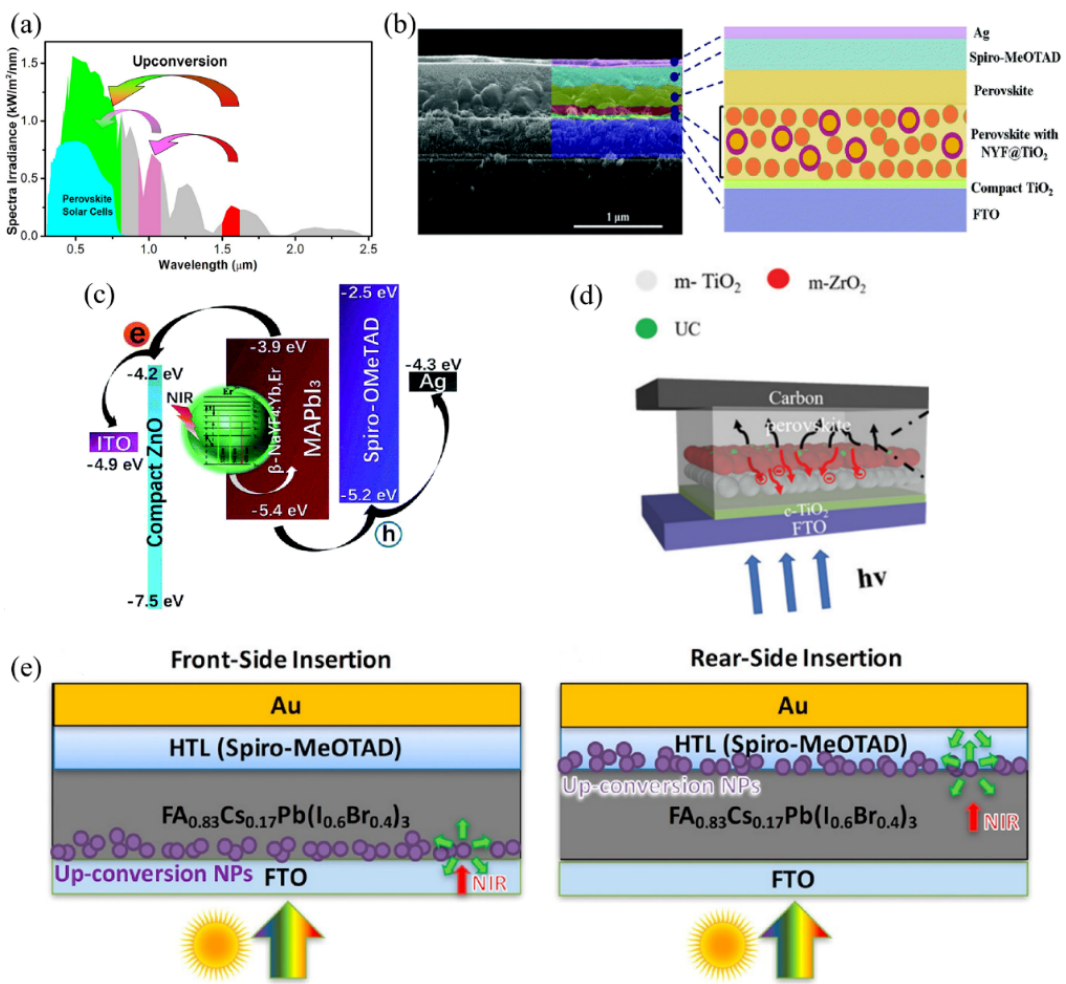
Figure 2. ( a ) The absorption regions of perovskite solar cells in the AM 1.5G solar spectrum via the up-conversion processes (Reprinted/adapted with permission from Ref. [22]. Copyright 2016 American Chemical Society); ( b ) Cross-sectional SEM image and schematic diagram of FTO/compact-TiO 2 /NaYF 4 :Yb/Er-CH 3 NH 3 PbI 3 /Spiro-MeOTAD/Ag (Reprinted/adapted with permission from Ref. [24]. Copyright 2016 RSC Pub); ( c ) Energy transfer illustration in the device of ITO/ZnO/ β -NaYF 4 :Yb/Er-CH 3 NH 3 PbI 3 /Spiro-OMeTAD/Ag (Reprinted/adapted with permission from Ref. [25]. Copyright 2017 RSC Pub); ( d ) Diagrams for device structure of FTO/cp-TiO 2 /mp-TiO 2 /mp-ZrO 2 -NaYF 4 :Ho 3+ /FA 0.4 MA 0.6 PbI 3 /C and mechanism of NIR light harvesting and up-conversion processes (Reprinted/adapted with permission from Ref. [24]. Copyright 2018 RSC Pub); ( e ) I Sketch maps for device structure of FTO/FA 0.83 Cs 0.17 Pb(I 0.6 Br 0.4 ) 3 /Spiro-MeOTAD/Au with inserting KY 7 F 22 :Yb 3+ , Er 3+ UCNPs at the front- or rear-side of perovskite layer (Reprinted/adapted with permission from Ref. [28]. Copyright 2018 American Chemical